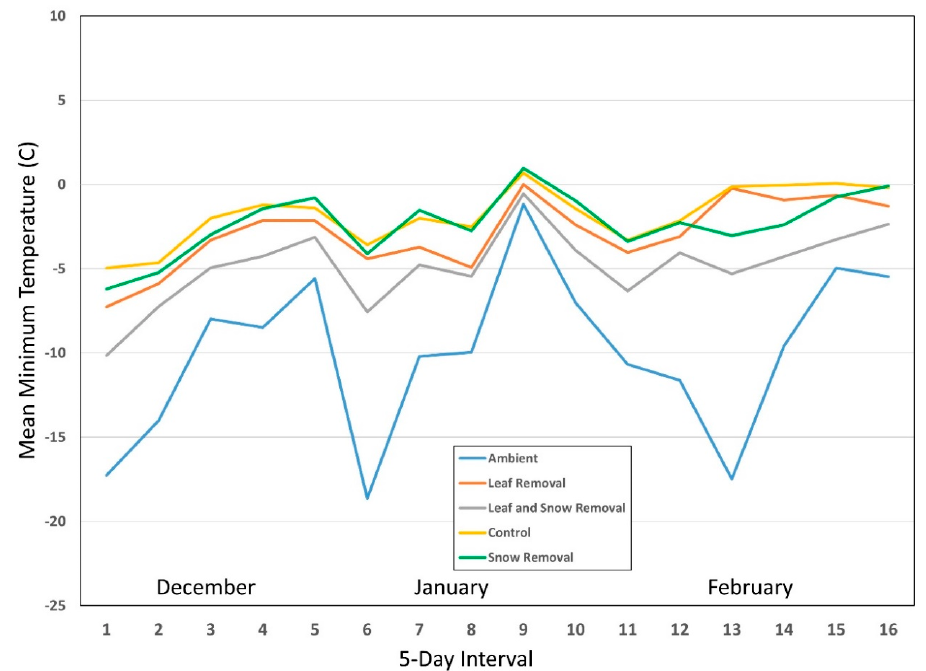
Figure 2. Year 2 mean minimum temperatures (°C) for all four treatment types and ambient temperature for 5-day intervals starting from mid-December through to the end of February for Connecticut and Maine combined.